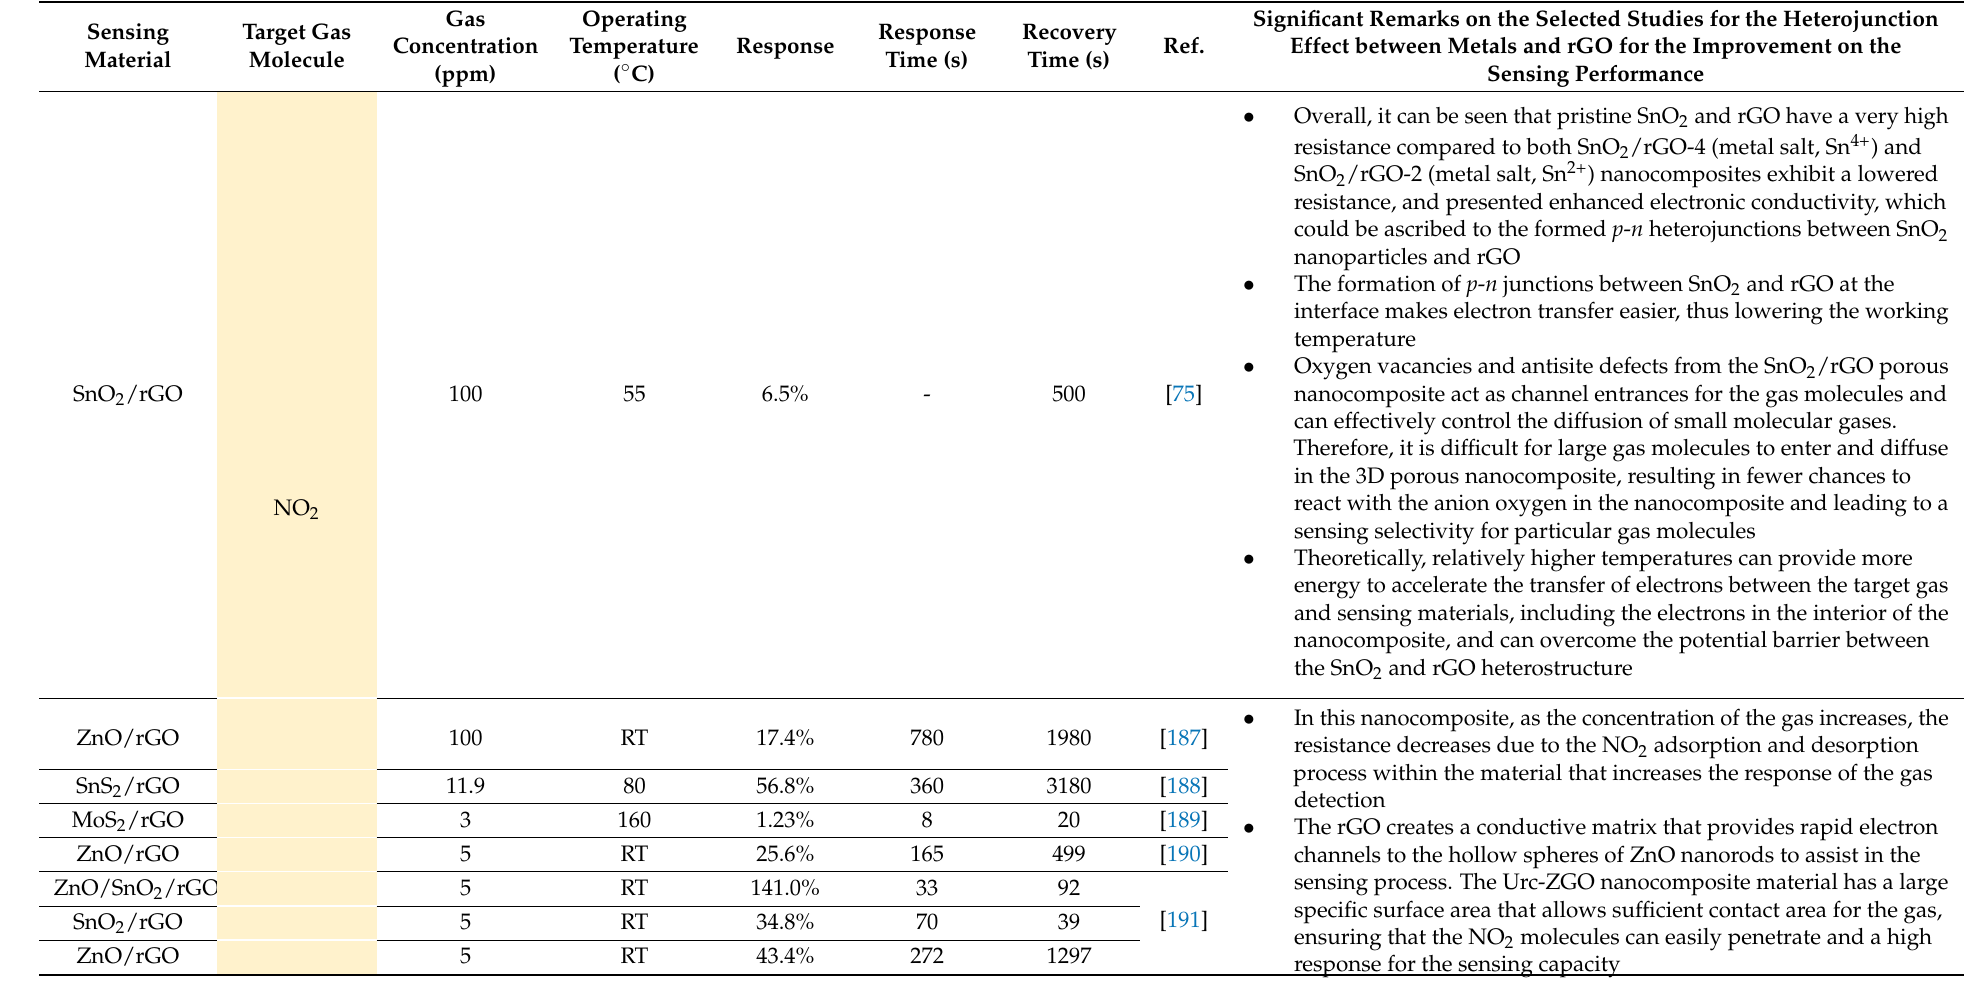
Table 5. Summary of the latest advances in rGO/metal oxide-based gas sensors for detection of the selected toxic